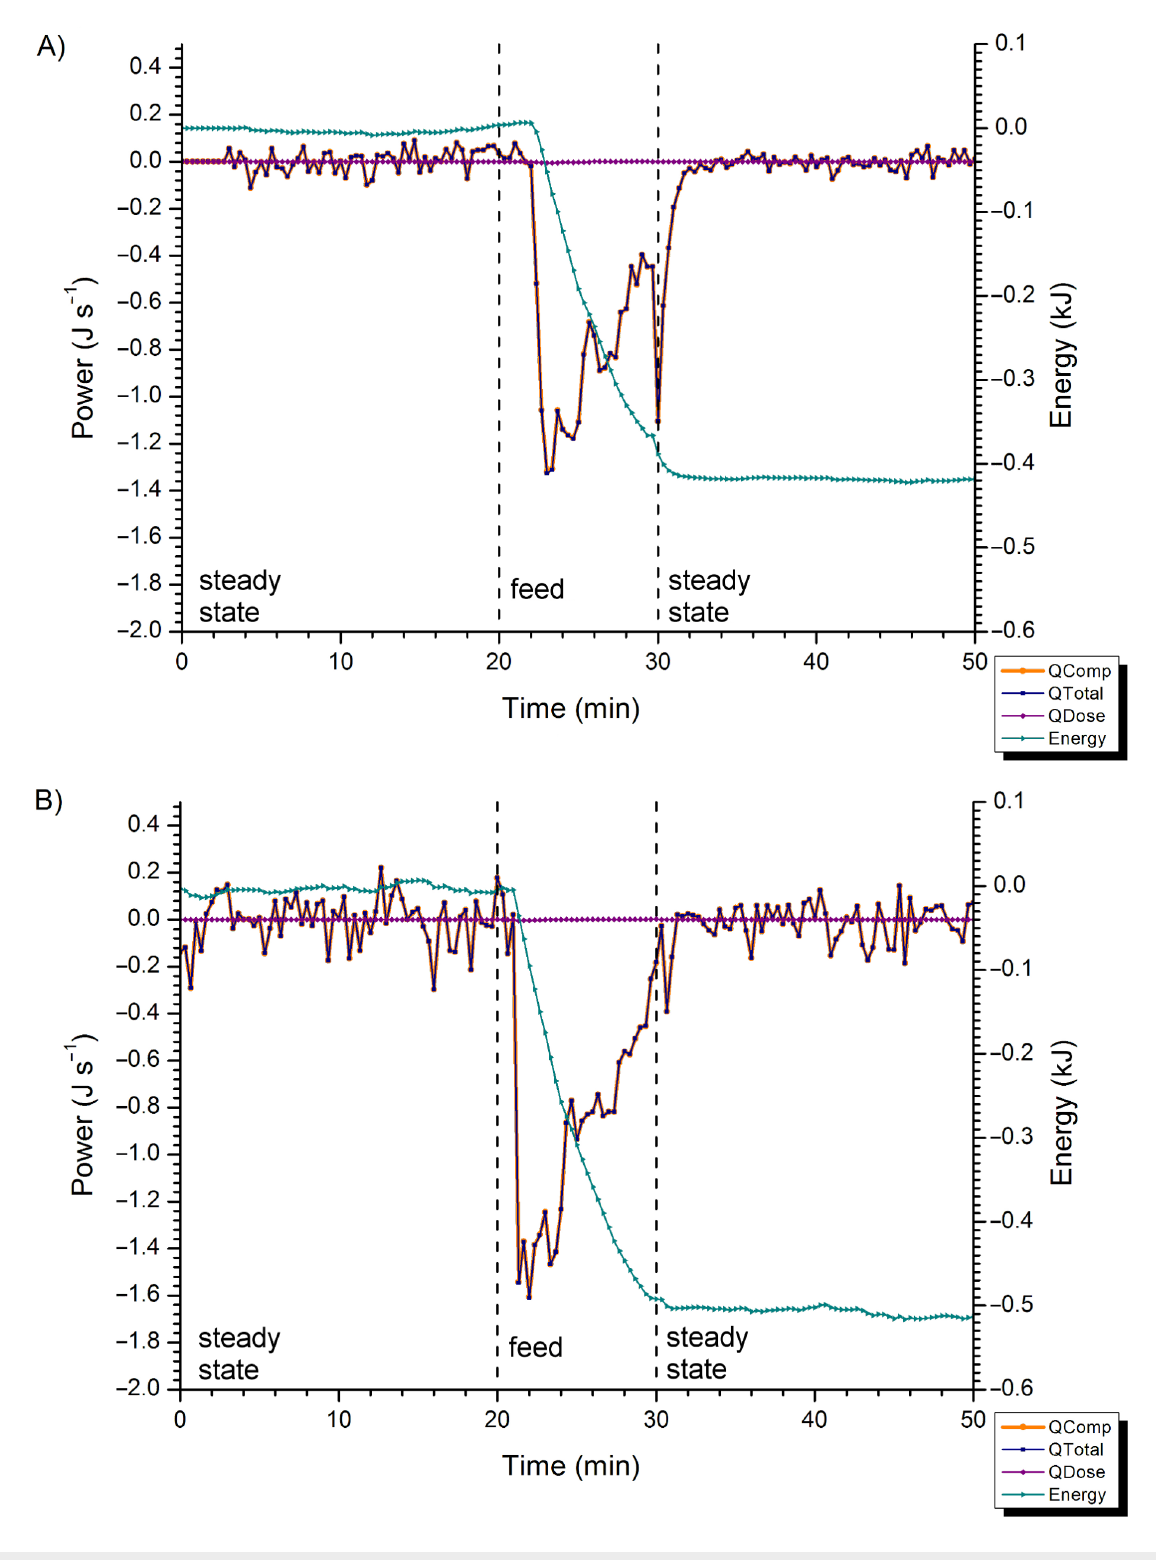
Figure 1: Calorimeter traces for the addition of aqueous NaCN (A) or water (B) to a solution of 6 and DABCO in acetonitrile. QComp: compensatory power; QTotal: total power; QDose: power generated due to the temperature and heat capacity of the feed; energy: heat energy. Because QDose ≈ 0 over the course of the experiment, traces for QComp (orange) and QTotal (blue)